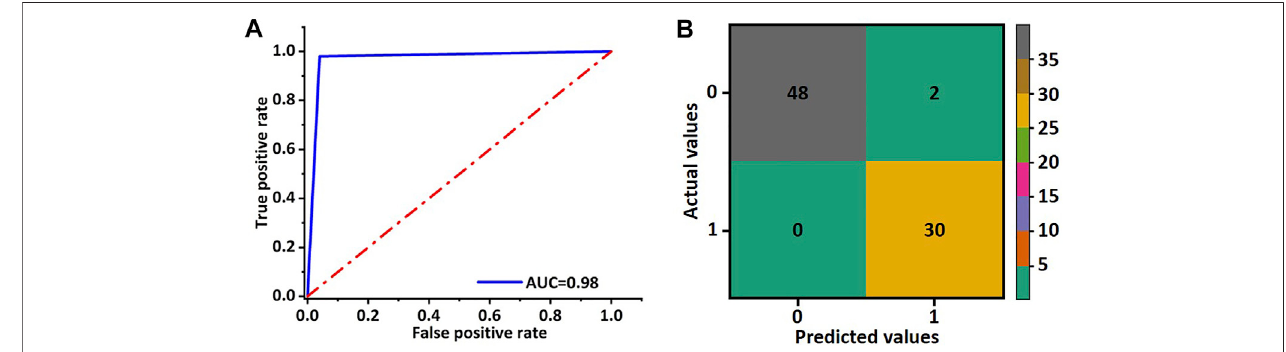
FIGURE 4 | Receiver operating characteristic curve and confusion matrix of validation cohort for the ghost network. (A) The AUC value of the ROC was used to evaluate the training effect of the model. (B) The accuracy of the ghost model in image classi fi cation was evaluated by the obfuscation matrix.